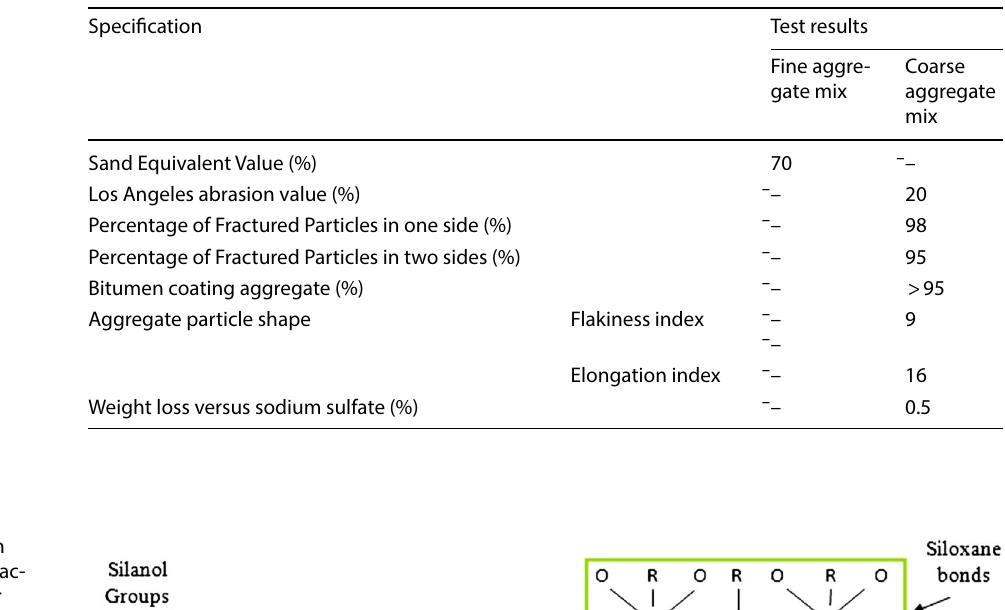
Fig. 2 Zycosoil bonds with material surface, before reac- tion with zycosoil ( a ), after reaction with zycosoil ( b )